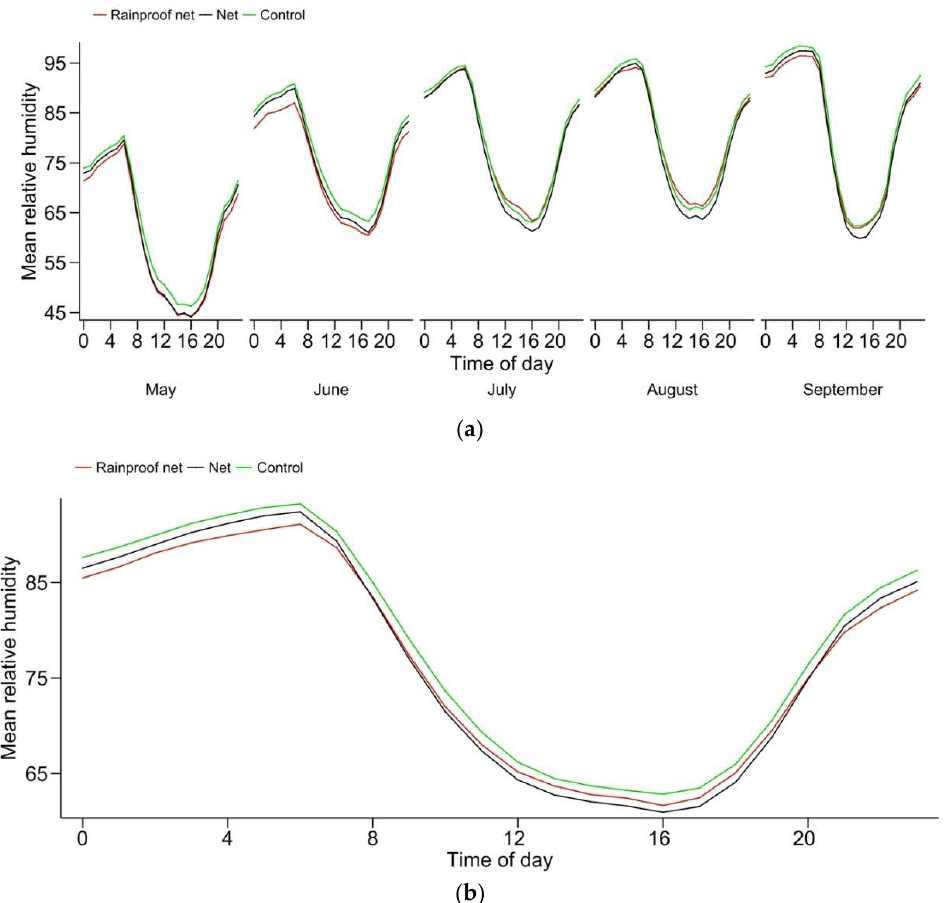
Figure 2. Mean hourly in-canopy relative humidity (May–September 2013, 2015, 2016 and 2017): ( a ) averaged per month over years and ( b ) seasonally averaged.